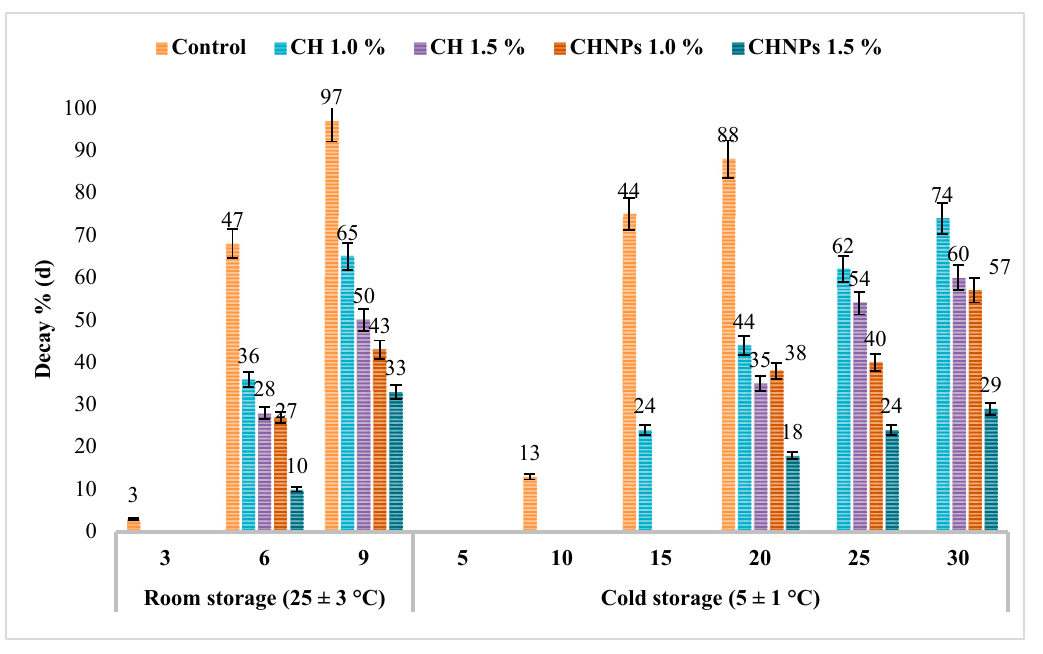
Figure 3. Effect of coating on apricot fruits’ visual decay percentage during storage.